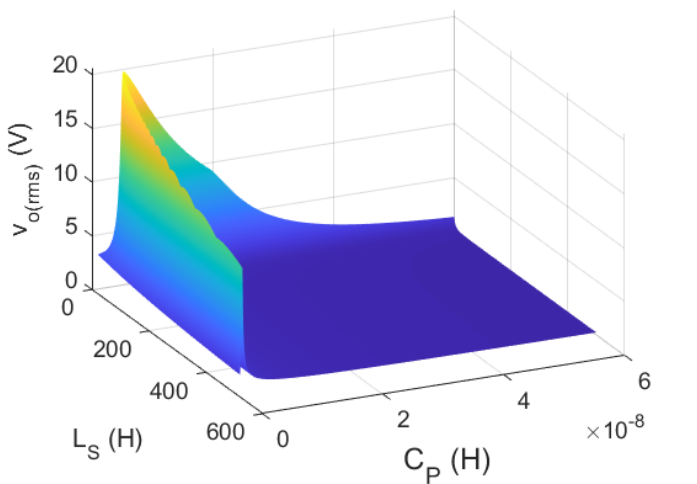
Figure 4. Root mean square of the output voltage as a function of the matching network parameters L S and C P for the nonlinear bi-stable energy harvester.